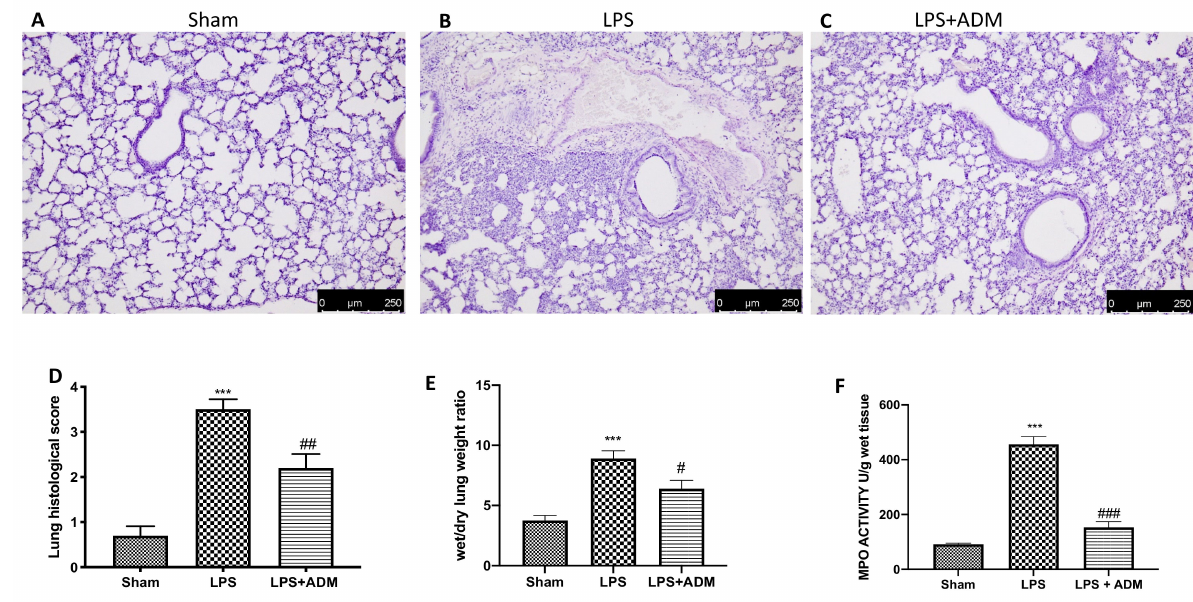
Figure 1. Histological analysis: sham ( A ), LPS ( B ), LPS + ADM 2% ( C ). Histological score ( D ). Wet/dry lung weight ratio ( E ). MPO activity ( F ). A 10 × magnification is shown. Data are expressed as the mean ± SEM of N = 6 mice/group. *** p < 0.001 vs. sham; # p < 0.05 vs. LPS; ## p < 0.01 vs. LPS; ### p < 0.001 vs. LPS.